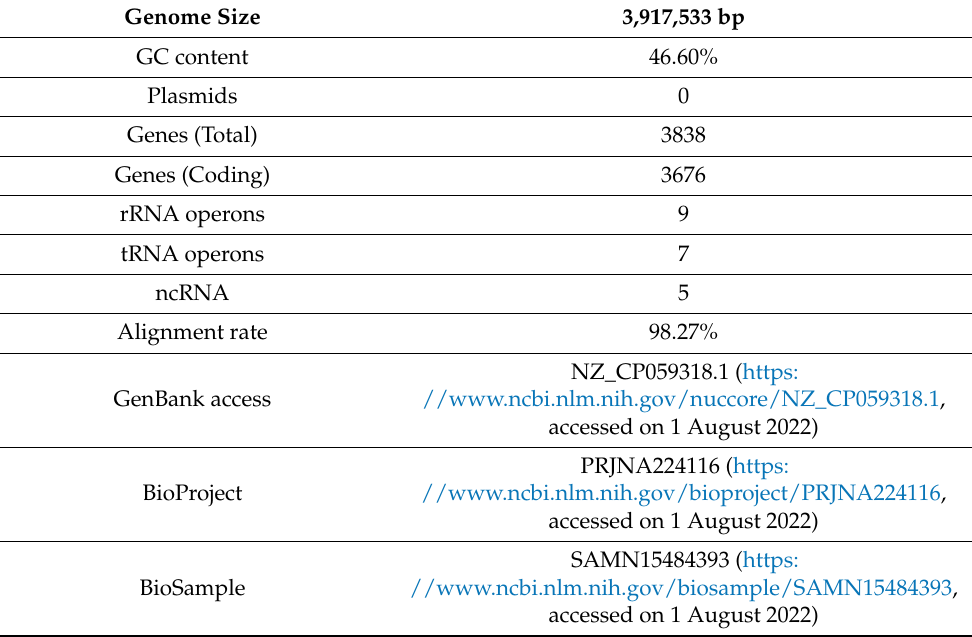
Table 2. General characteristics of B.BV10 genome assembly according to the PGAP pipeline.